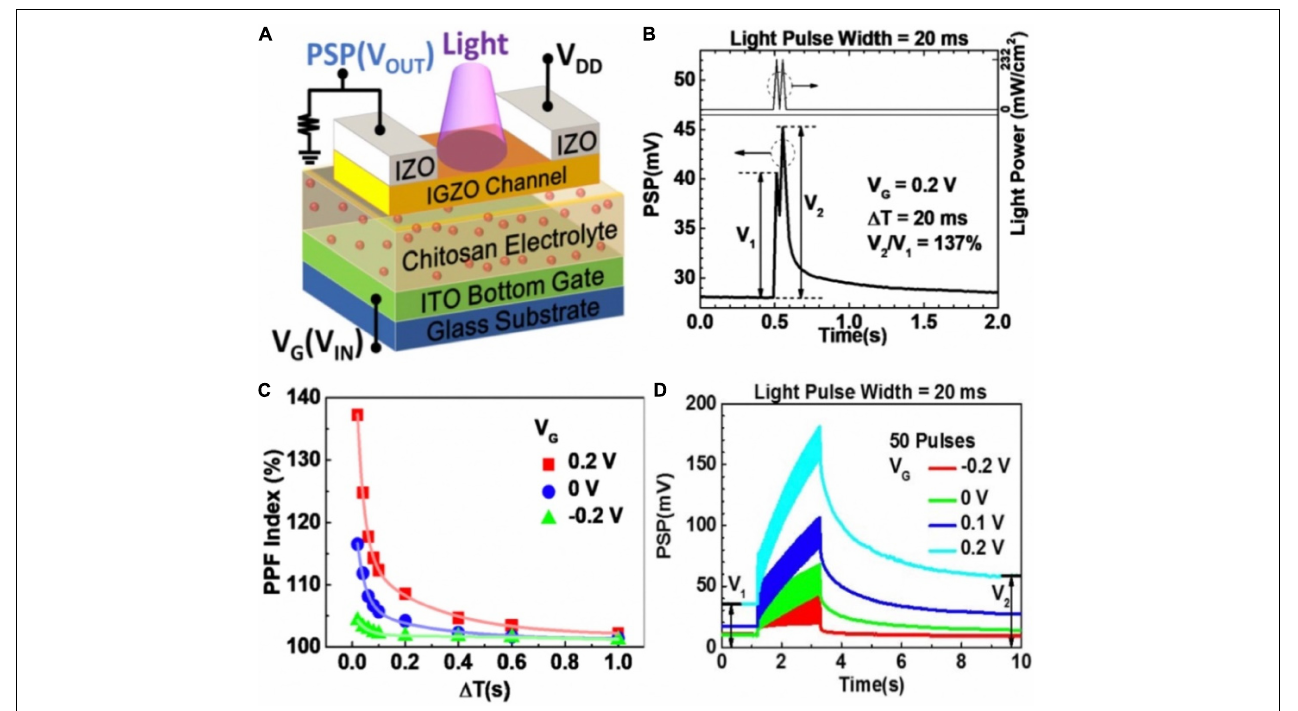
FIGURE 10 | (A) Schematic diagram of the photonic neuromorphic transistor loaded with a resistor. (B) PPF realized in the synaptic transistor with light input pulses. (C) PPF index decreases with increased (cid:49) T under various V G . (D) EPSPs triggered by a series of 50 light pulses under different V G (adapted from Yang Y. et al.,